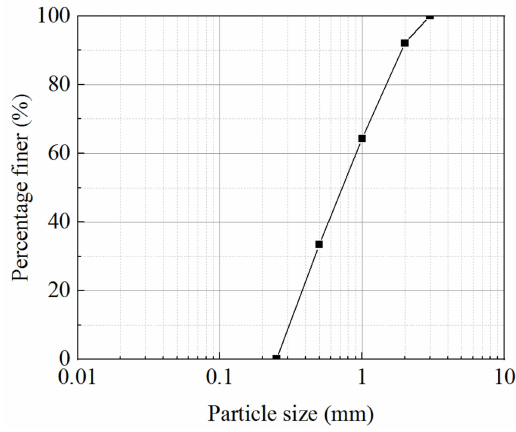
Figure 1. Grain size distribution curve of Fujian